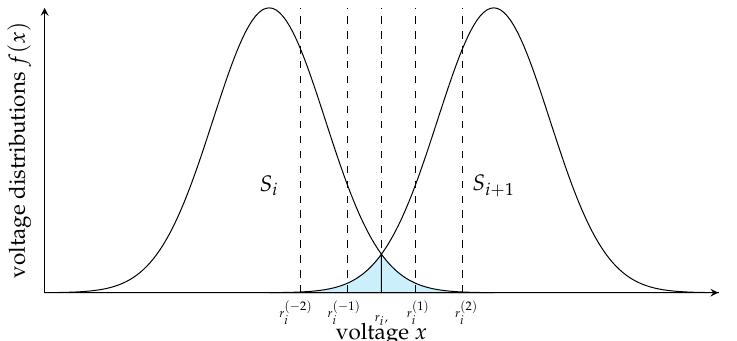
Figure 2. Voltage distributions with soft